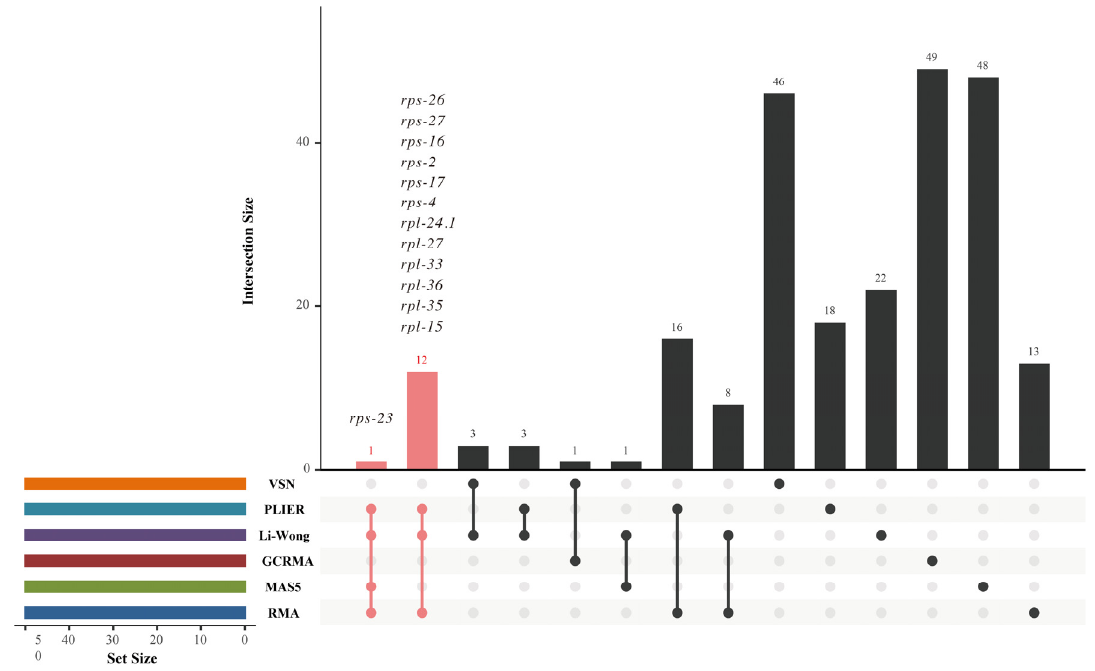
Figure 2. Intersection analysis of top 50 genes from each SGL.